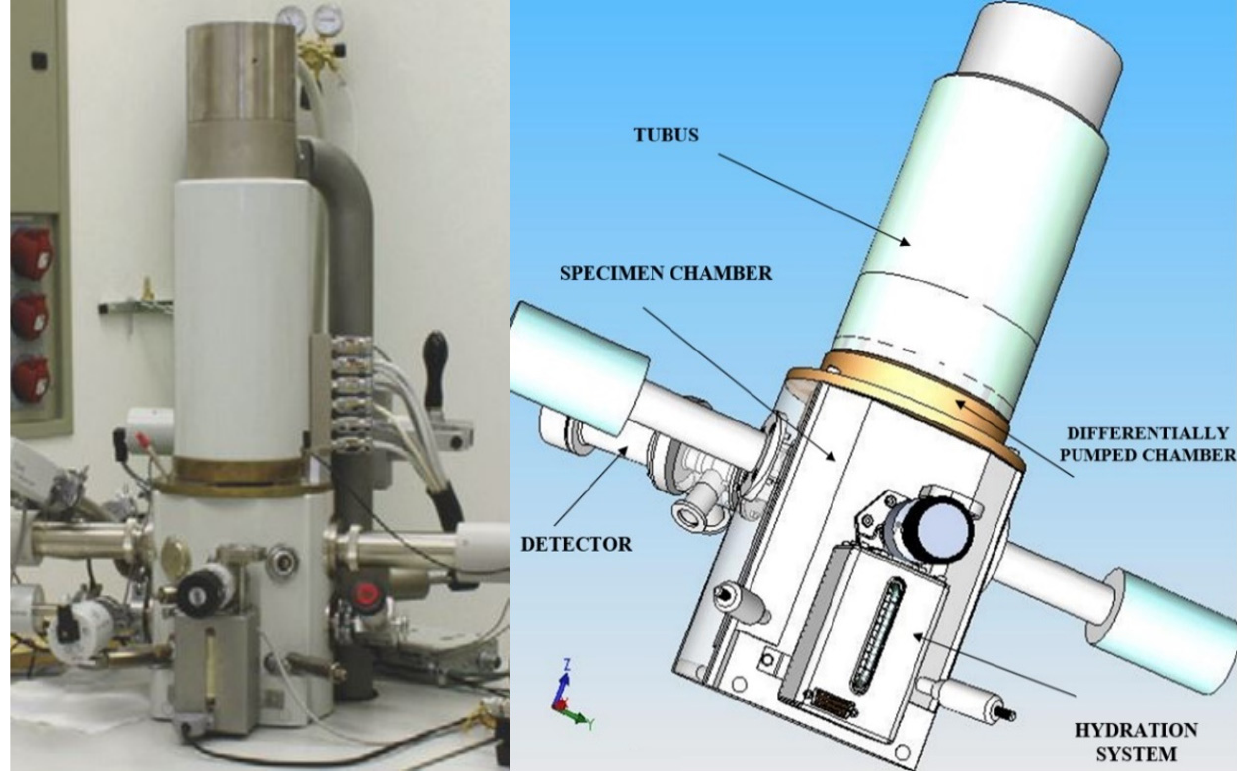
Figure 1. Electron microscope AQUASEM II.